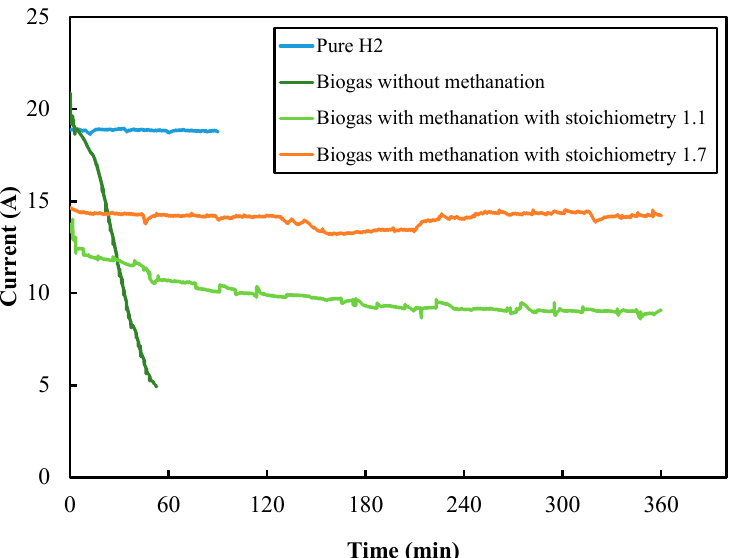
Figure 8. Comparison of the variation of the output current using pure H 2 , with and without the methanation reforming method.